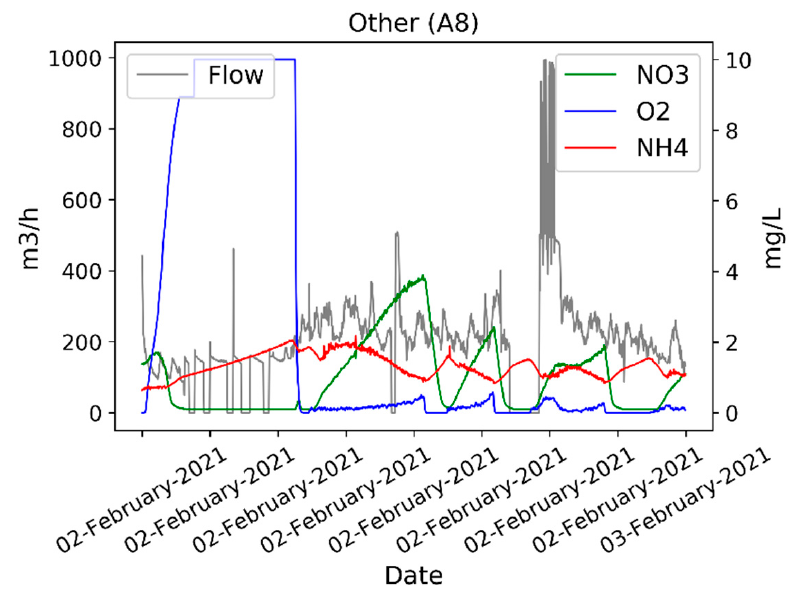
Figure 7. Example of an anomaly detected in WWTP2 PCT2. The anomaly is categorized as other. The anomaly is most likely caused by a fault in the DO sensor.